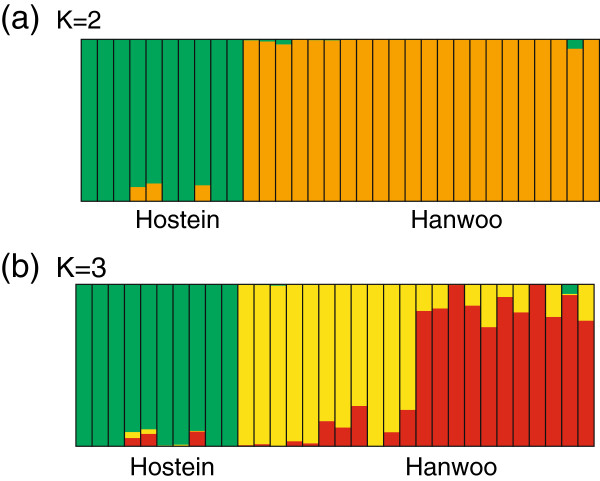
Population structure analysis using structure. Each individual is represented by a vertical bar, and the length of each colored segment in each of the vertical bars represents the proportion contributed by ancestral populations. (a) Two colors (K = 2) mostly represent population structure of 32 individuals. (b) Three colors (K = 3) represent population structure of 32 individuals.